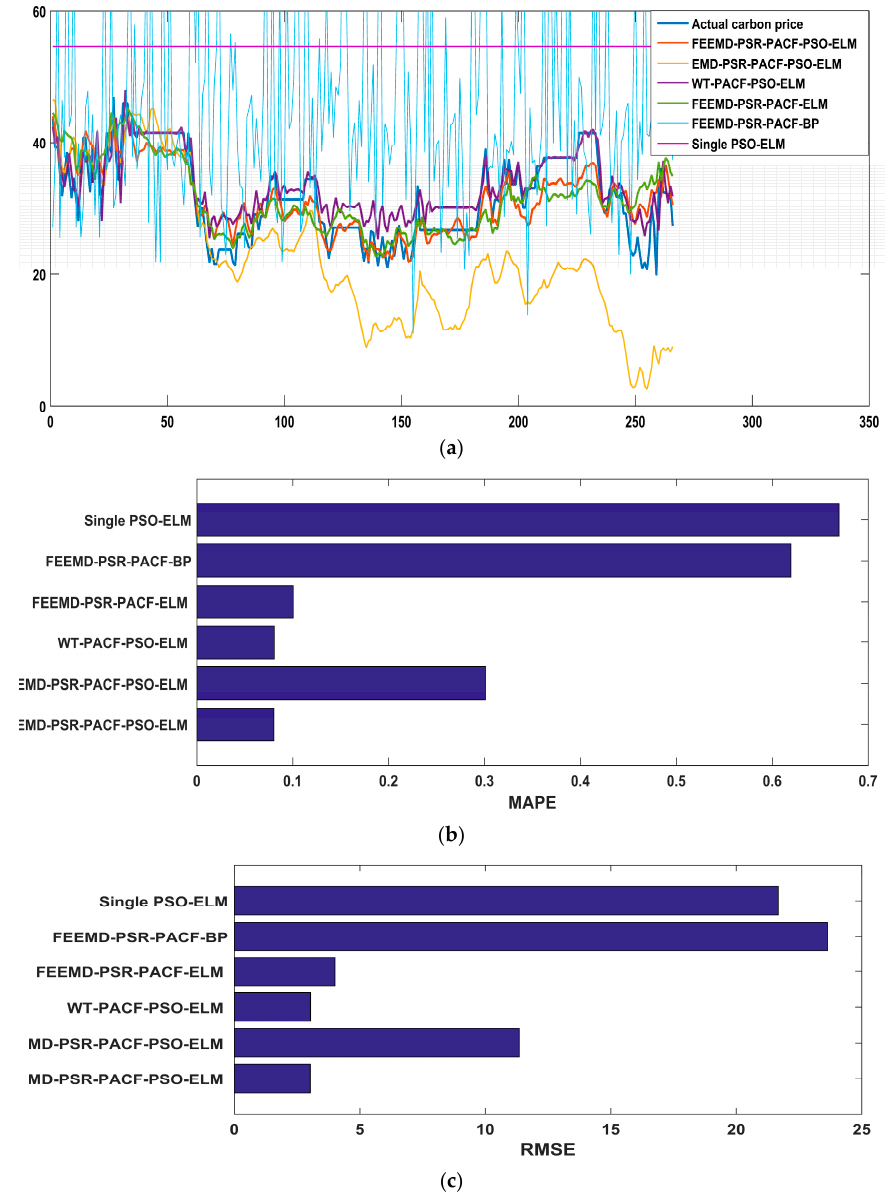
Figure 13. ( a ) The forecasting curves of the Shenzhen carbon price; ( b ) The MAPE values; ( c ) The RMSE values.